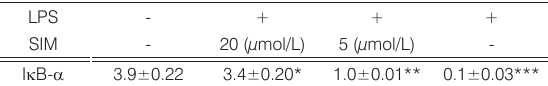
Table 4. The effect of simvastatin with the different concentration on the I k B- a .